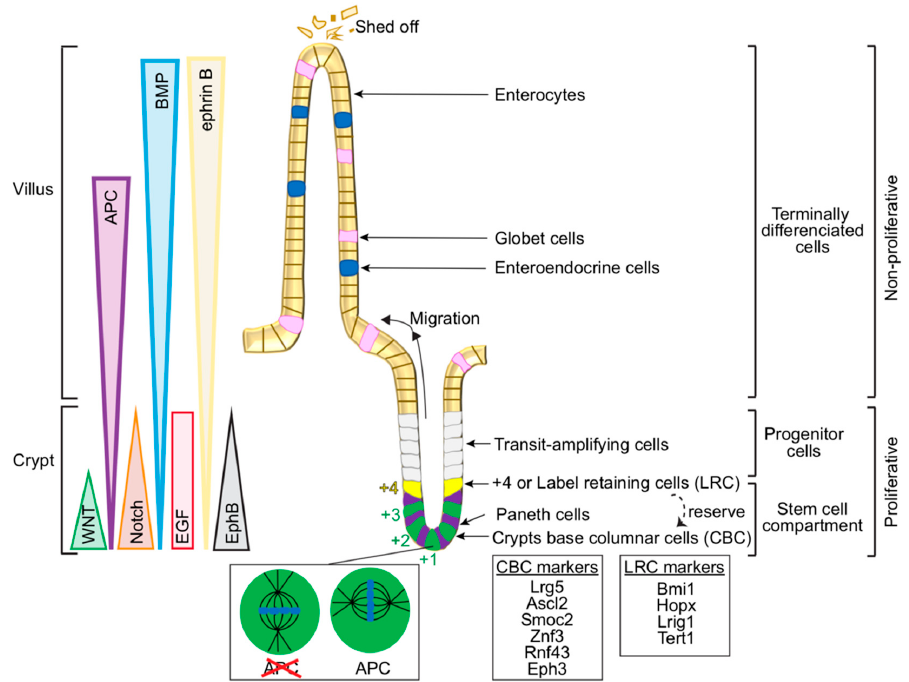
Figure 1. Small intestinal epithelium organisation and signalling pathways. Schematic of the gut epithelium depicting the signalling gradients that control cell homeostasis, as well as cell types, including stem cell populations—the crypt base columnar cells (CBC) at the bottom of the crypt and the label ‐ retaining cells (LRC) at the +4 position, and respective markers. Zoom into a stem cell at the bottom of the crypt (+1), showing Apc ‐ dependent orientation of the mitotic spindle. According to [62], the mitotic spindle orients preferentially perpendicular to the apical surface in the presence of Apc but favours a parallel orientation in the absence of Apc . Brackets define the cellular compartments containing proliferative cells (stem cells and transit ‐ amplifying cells), and non ‐ proliferative cells (terminally differentiated cells—enteroendocrine cells, globet cells and enterocytes. Differentiated cells actively migrate up to the top of the tip villus where they shed off.